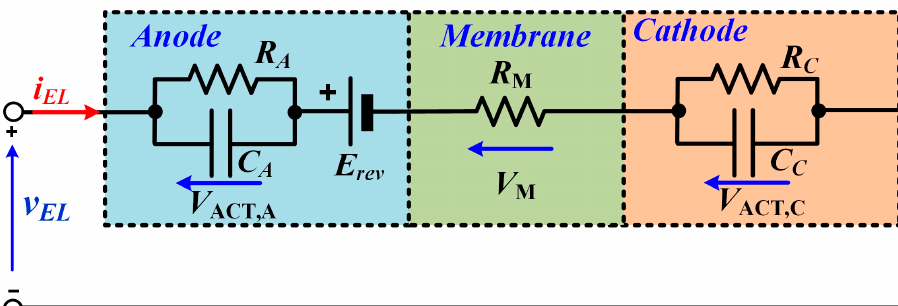
Figure 12. Equivalent electrical circuit of the electrolyzer emulator.